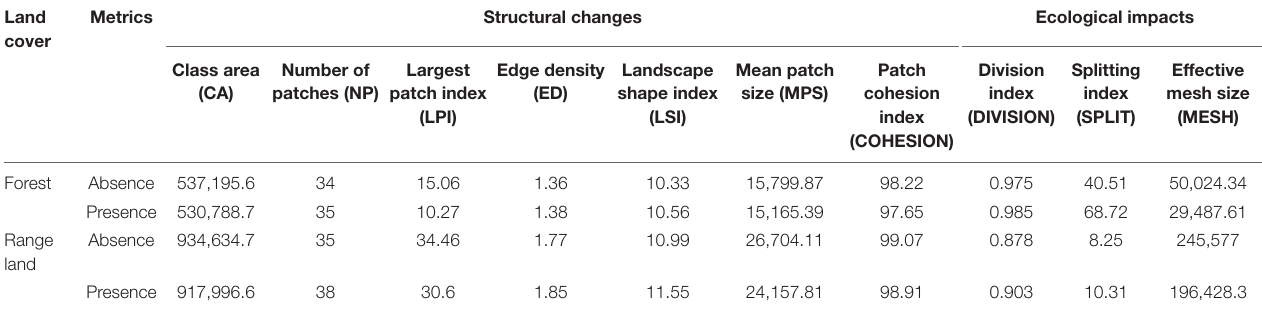
TABLE 2 | Assessing habitat degradation and fragmentation of the forest and range land cover before and after construction of the Isfahan-Shiraz highway. Land Metrics Structural cover